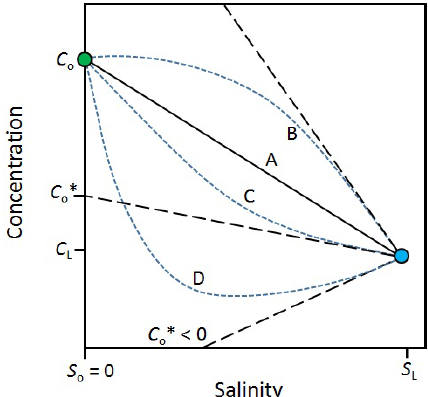
Figure 3. Variations in the concentration of a solute along a salin- ity gradient in an estuary. c L , s L – solute concentration and salinity in the sea; c o , s o – solute concentration and salinity in the river; line A – mixing only (no solute production or consumption in the estuary). Line B – solute production in the estuary. Lines C and D – solute consumption in the estuary; c ∗ o – effective solute concen- tration. The tangents off lines B, C and D (black dashed lines) are used to infer c ∗ o . For line D, c ∗ o <0, which means the estuary is also a sink for solutes imported by mixing from the sea. Modified from Officer